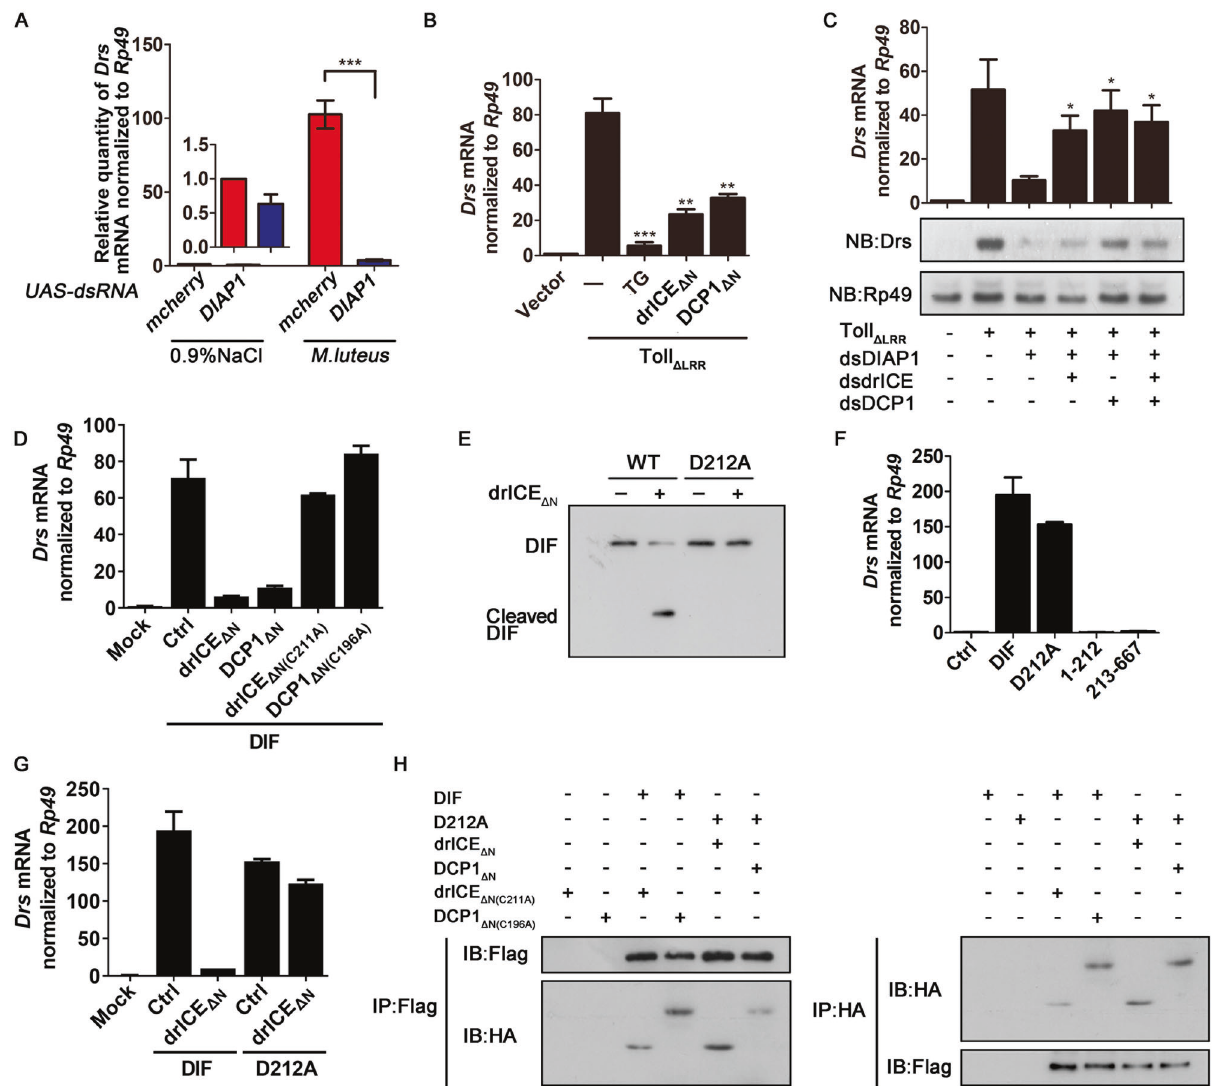
Fig. 5 DrICE and DCP-1 cleave DIF in Drosophila. A At 6 h post M. luteus challenge, total RNA extracts were prepared from adult fl ies with the indicated genotypes and treatments, and subjected to qRT-PCR of Drs mRNA normalized by Rp49. Each group contains 10 female fl ies and 10 male fl ies. B Quantitative RT-PCR analysis of Drs mRNA in S2 cells transfected with HA-tagged Toll Δ LRR , together with drICE Δ N or DCP1 Δ N or treatment with TG. C Quantitative RT-PCR analysis of Drs mRNA in S2 cells transfected with HA-tagged Toll Δ LRR together with indicated dsRNAs. Total RNA extracts were prepared and detected via Northern blots using the indicated probes. D Quantitative RT-PCR analysis of Drs mRNA in S2 cells transfected with plasmids as indicated. E Immunoblot of puri fi ed WT and D212A mutant of DIF proteins incubated without ( − ) or with puri fi ed drICE Δ N ( + ) for 60 min at 37 °C. The blot was probed with anti-Flag antibody. F , G Quantitative RT-PCR analysis of Drs mRNA in S2 cells transfected with plasmids as indicated. H The S2 cells were ectopically expressed with the indicated proteins for 48